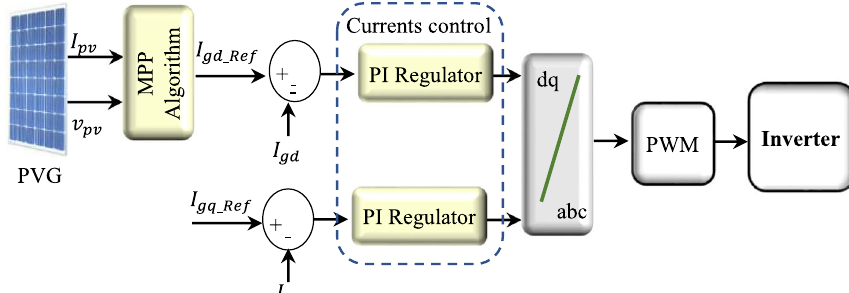
Fig. 4 Control strategy of the whole PV